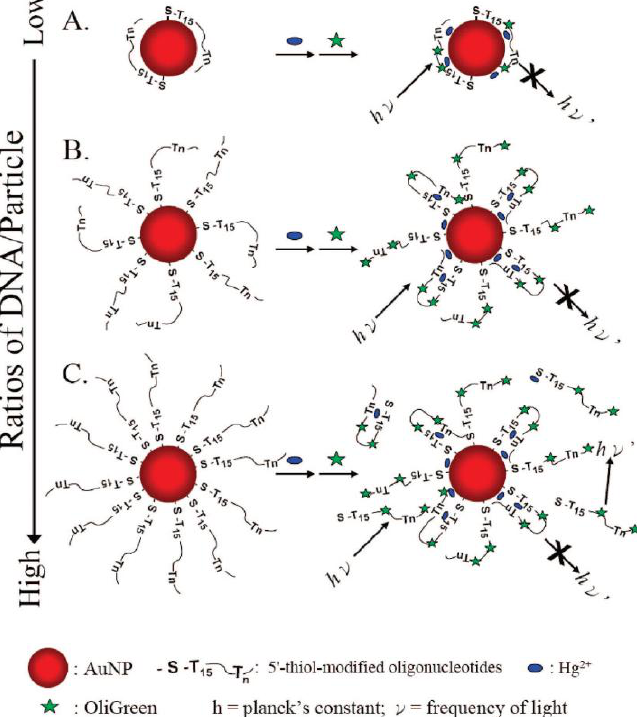
Figure 5. Schematic representation of Hg 2+ nanosensors at various DNA-to-Au NP molar ratios: (a) <30, (b) 30–50, and (c)  60. Reprinted with permission from Ref.